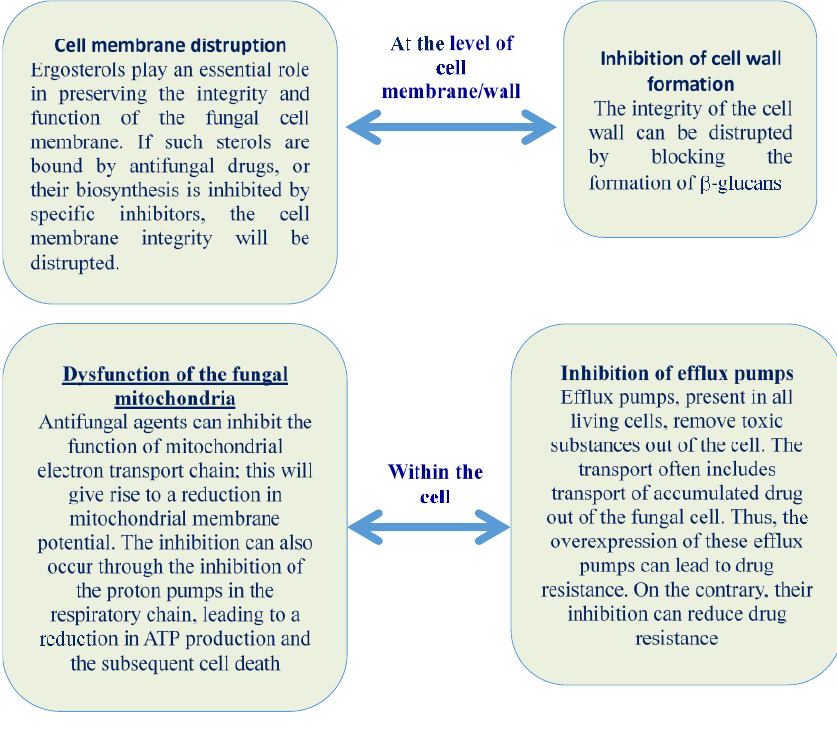
Figure 1. EOs action against fungi.